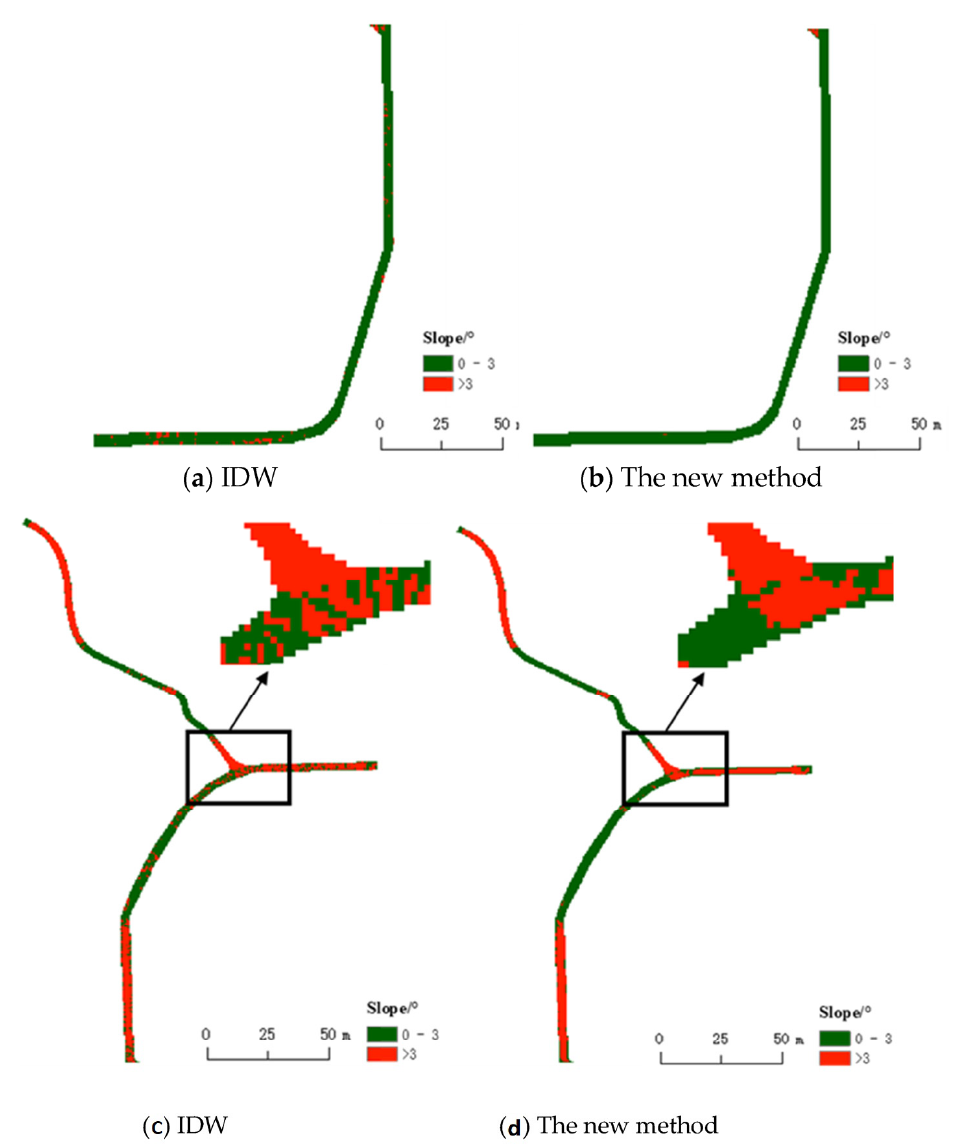
Figure 8. Road extraction slope map.